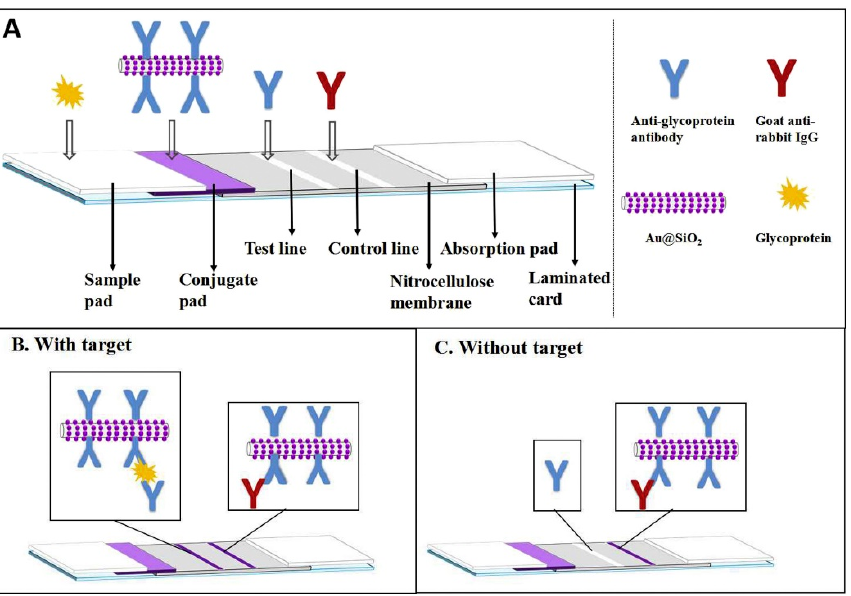
Figure 5. The operating principle for the detection of glycoprotein using the lateral flow immunoassay. ( A ) Sketch of the setting of the test strip. ( B ) illustration of the typical recognition mechanism when the molecular target is present. ( C ) Illustration of the recognition mechanism in cases in which the target is absent. Reprinted from Ref [116], copyright 2019, with permission from